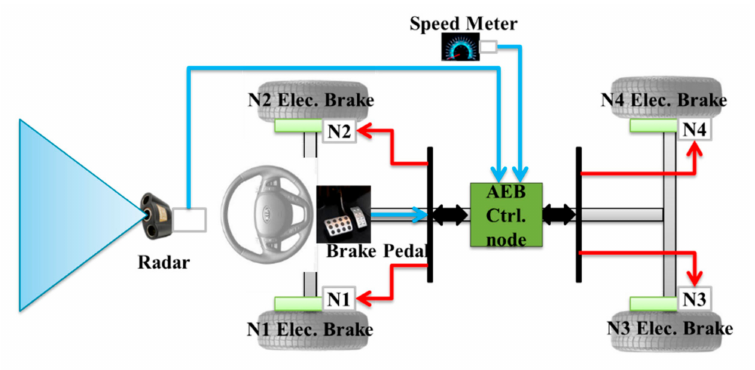
Figure 6. Functional block diagram of AEB